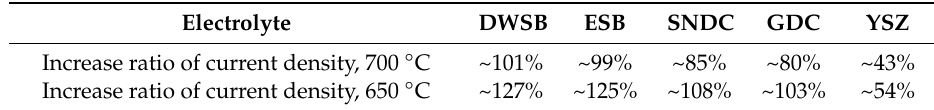
Table 6. The cell current density versus the change of the activation energy (by 10% decrease of the activation energy) with di ff erent